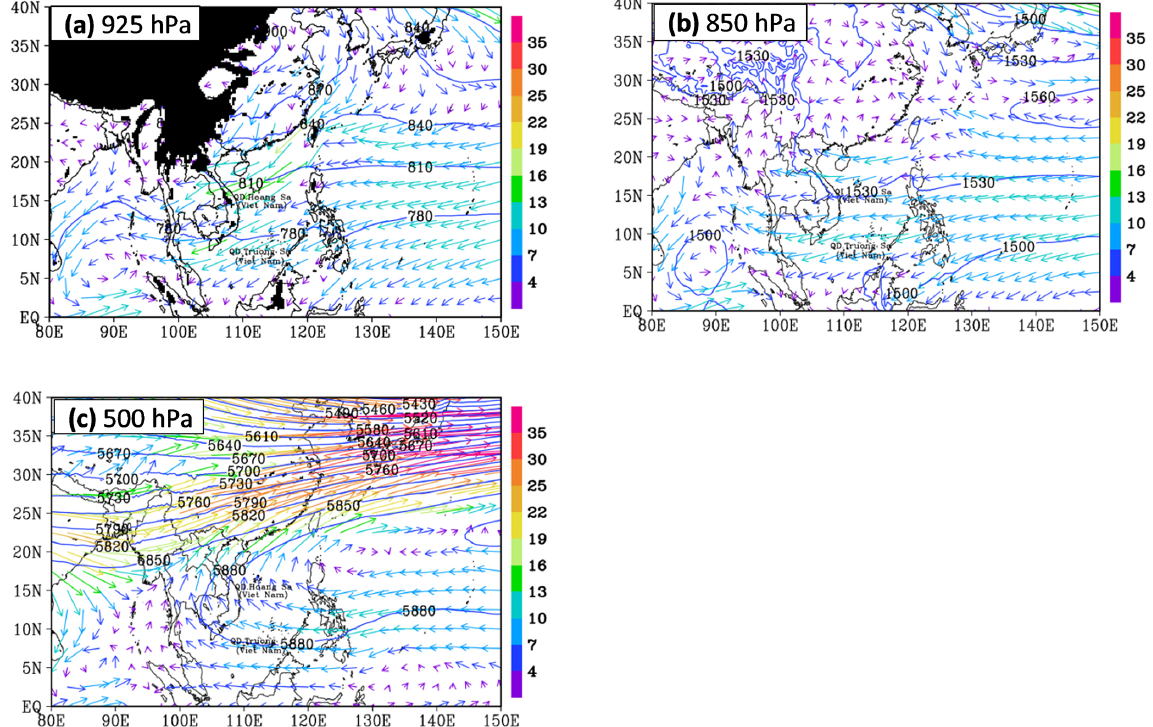
Figure 3. (a) The ERA5 averaged horizontal wind vectors (ms − 1 , color for speed) and geopotential height (gpm, blue contours, every 30gpm) at the 925hPa from 00:00UTC on 8 December to 18:00UTC on 11 December 2018. (b) As in panel (a) , but for the 850hPa. (c) As in panel (a) , but for the 500hPa. The black areas are where the 925hPa level is below the ground.